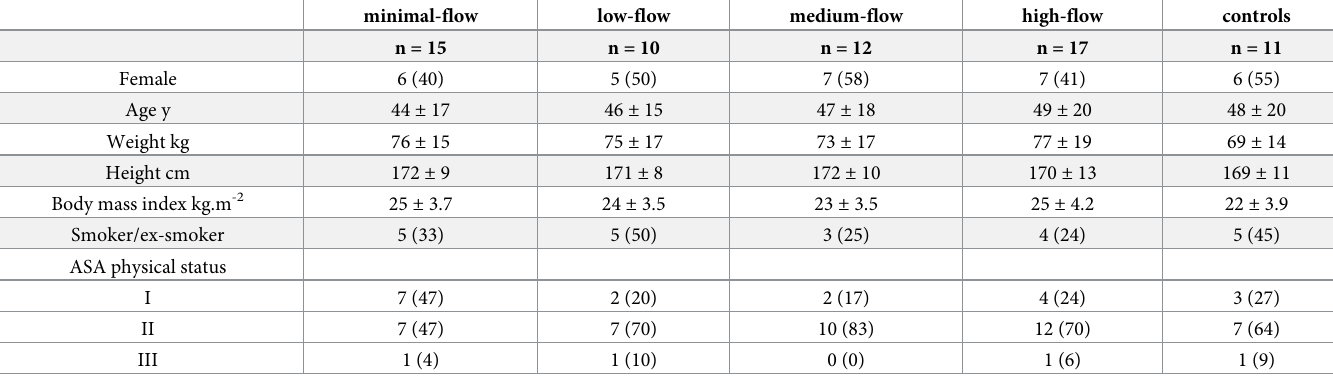
capacity, the same phenomenon seems not to occur in apneic, anaesthetized and muscle relaxed patients. Lung volume loss as a surrogate parameter for atelectasis formation occured indepen- dently of flow rates and was similar in all groups studied in this analysis. Multiple studies showed that HFNO prolongs safe apnea time and improves apneic oxygen- ation during intubation and airway management in adult and pediatric patients under general anesthesia [9, 10, 35–38]. However, none of these studies investigated changes in lung volume or compared different flow rates. A recent study investigated airway pressures during apneic HFNO. The researchers did not find an increase in airway pressure when the mouth of the patients remained open [17]. Our study adds further evidence that prolongation of the apnea period with HFNO occurs by an “aventilatory mass flow” of oxygen independently of the gen- erated airway pressures or lung volumes as already described over 60 years ago [39]. Despite the evident usefulness of HFNO to prolong the safe apnea period, it is now clear that the insig- nificant pressures generated in the airway cannot prevent atelectasis formation, which could be even provoked by the use of a high oxygen concentrations [22, 40, 41].